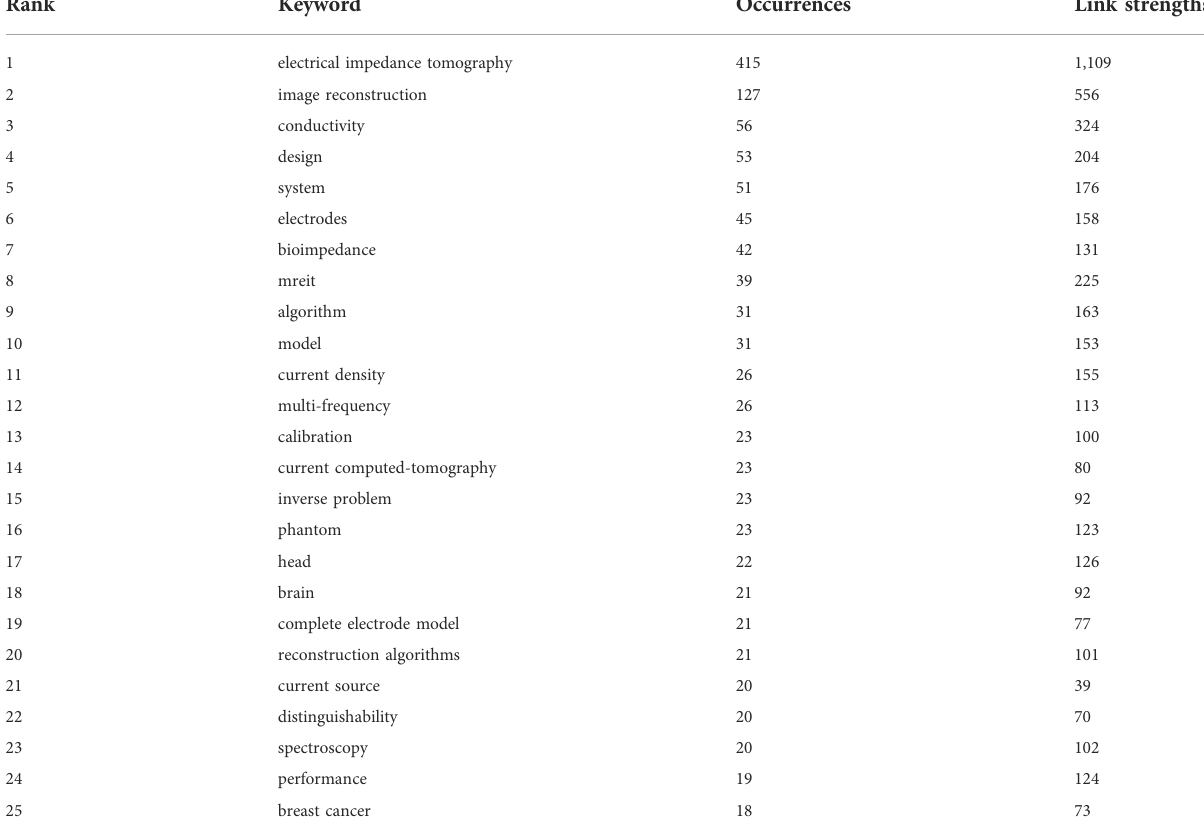
TABLE 3 Top 25 high frequency keywords on electrical impedance tomography hardware